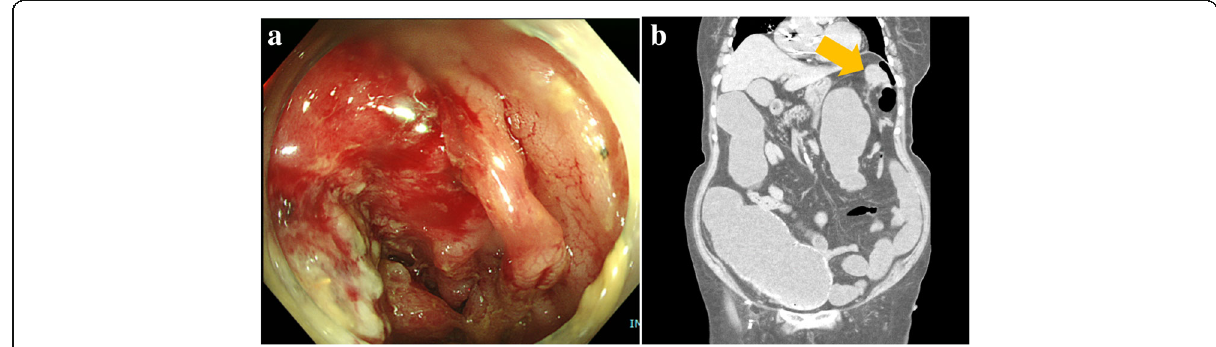
Fig. 1 Preoperative colonoscopy and computed tomography findings. a Colonoscopy confirmed descending colon cancer and obstruction. b Computed tomography revealed an obstructive ileus due to descending colon cancer (yellow